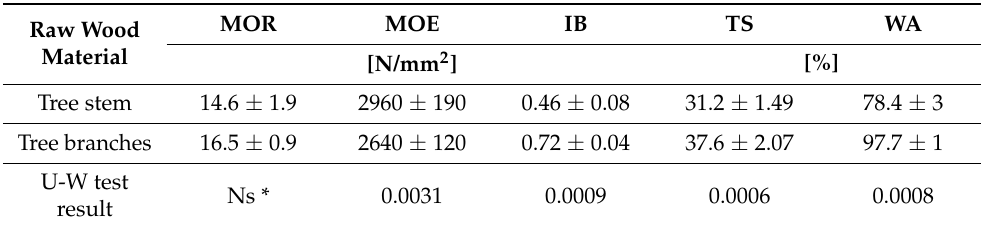
Table 4. The mean value and standard deviation of examined properties of 3-layer particleboards from tree stem and branches